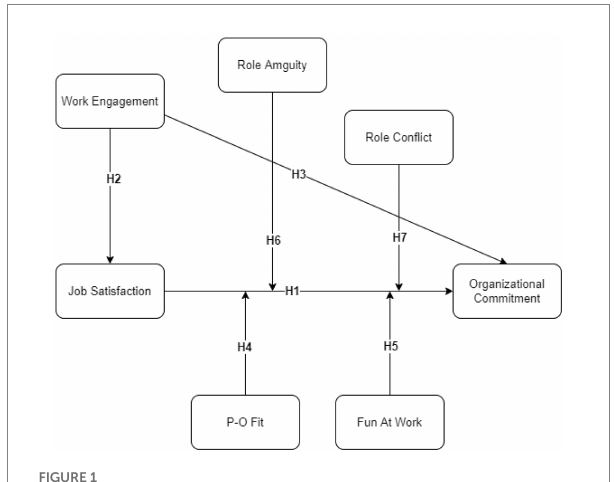
FIGURE 1 The conceptual